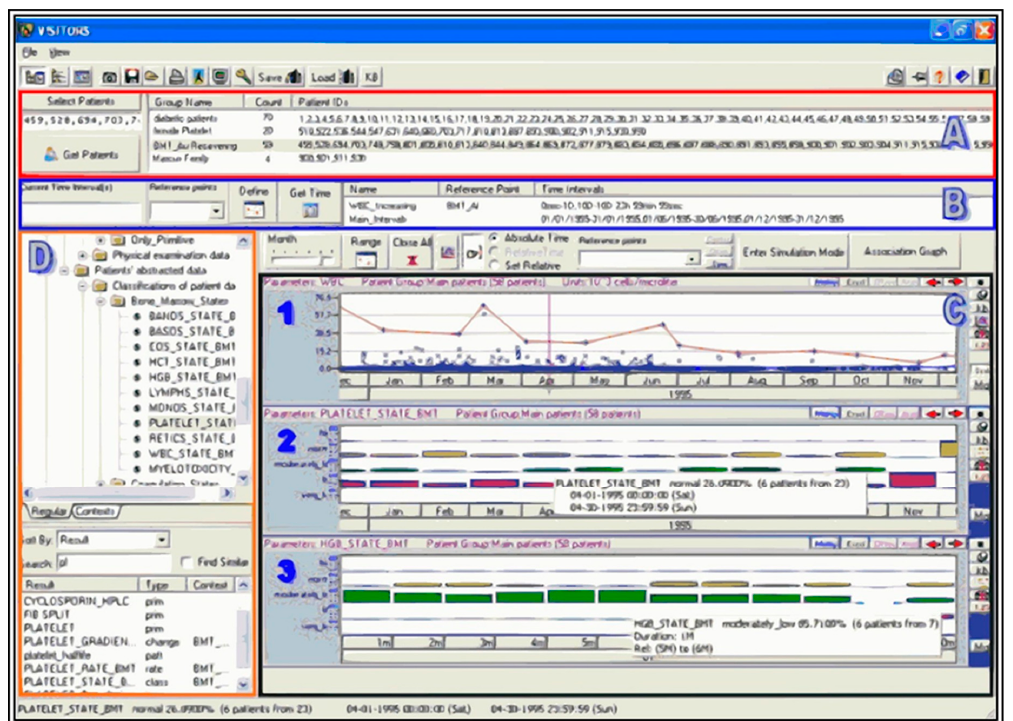
Figure 12. VISITORS: Interactive visualization tool for the exploration of multiple patient records. ( A ) displays lists of patients. ( B ) displays a list of time intervals. ( C ) displays the data for a group of 58 patients over the current time interval. Panel 1 shows the white blood cell raw counts for the patients, while Panels 2 and 3 display the states of monthly distribution of platelet and haemoglobin in higher abstraction, respectively. Abstractions are encoded in medical ontologies displayed in panels ( D ). Source: reprinted from Journal of Artificial Intelligence in Medicine, 49, Klimov D, Shahar Y, Taieb-Maimon M, Intelligent visualization and exploration of time-oriented data of multiple patients , 11-31., copyright (2010), with permission from Elsevier.